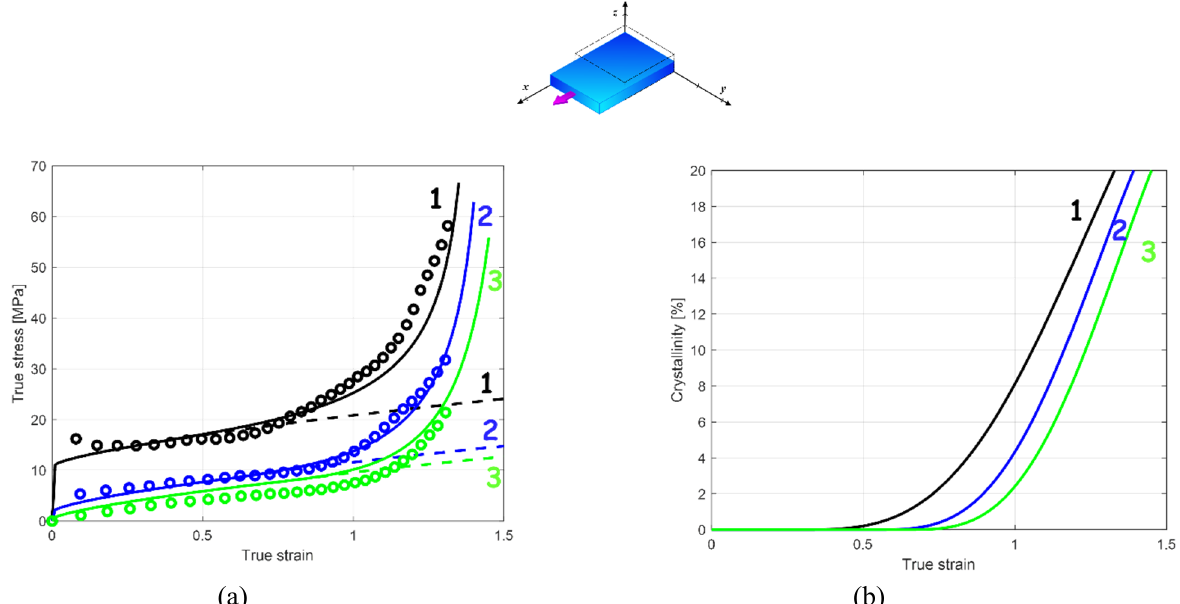
Figure 5. Model results under CW loading at a strain rate of 1 /s and different loading temperatures (1: 80 ◦ C, 2: 86 ◦ C, 3: 92 ◦ C): ( a ) stress–strain response, ( b ) strain-induced crystallization; solid lines: model; dashed lines: model with no crystallization; symbols: experimental data of Adams et al. [2].